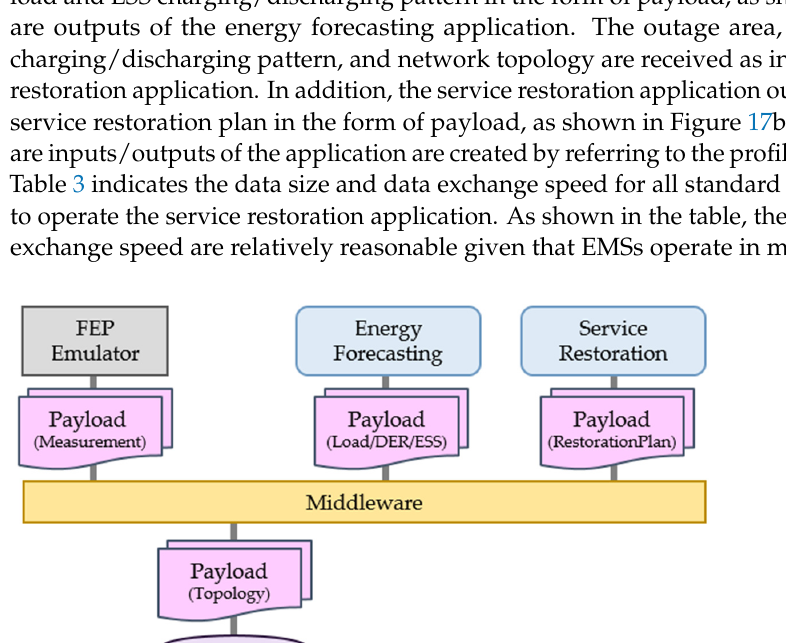
Figure 17. ( a ) Profile of the service restoration plan using the ESS; ( b ) Payload of the service restoration plan using the ESS.